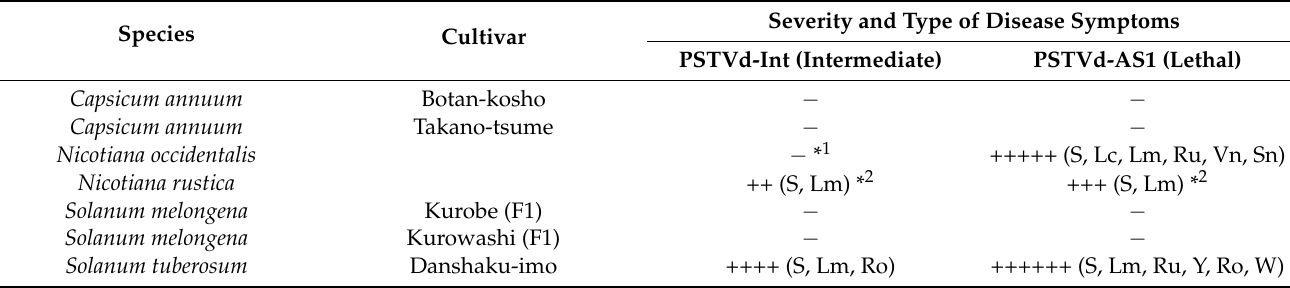
Table 3. Symptoms of five Solanaceae species infected with intermediate and lethal strains of